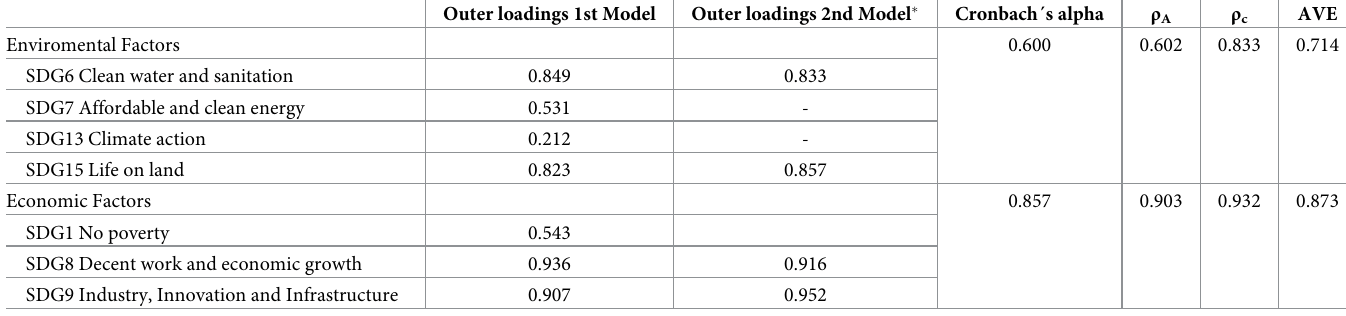
Table 3. Composites and